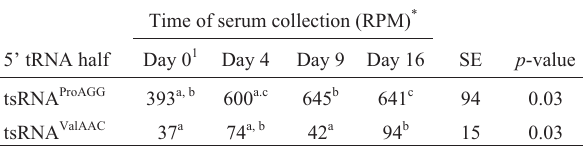
Table 1 - 5’tRNA-derived RNA halves, normalized mean for time of se- rum collection, standard error (SE), and their association (p-value) across all